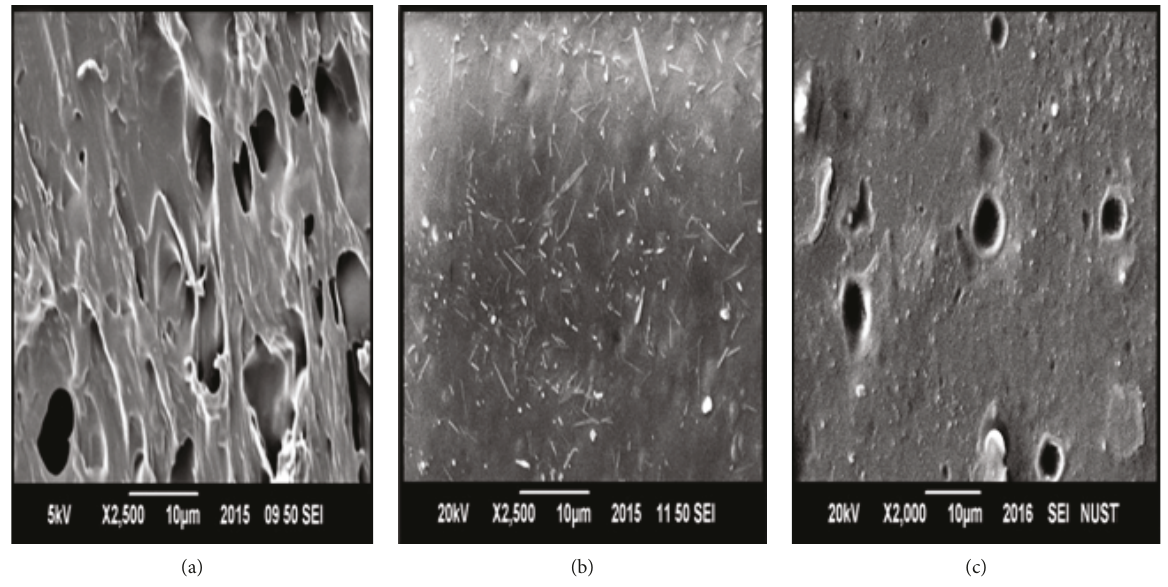
Figure 1: SEM micrographs representing the topographic view of the prepared hydrogels: (a) HG; (b) HGAA; (c)